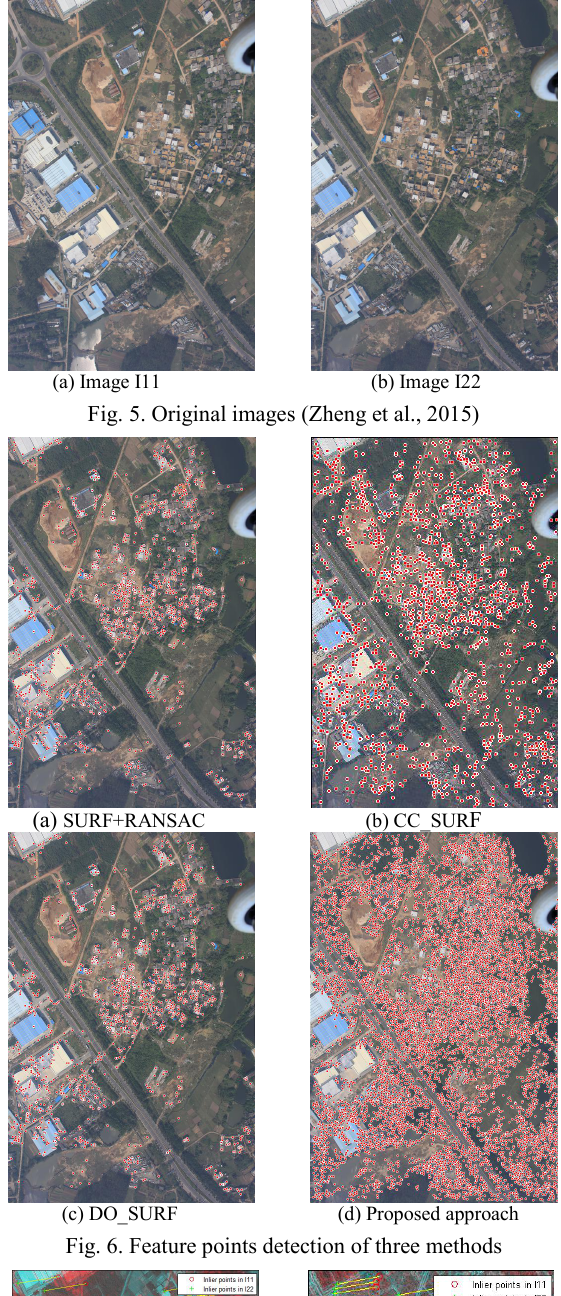
Fig. 6. Feature points detection of three